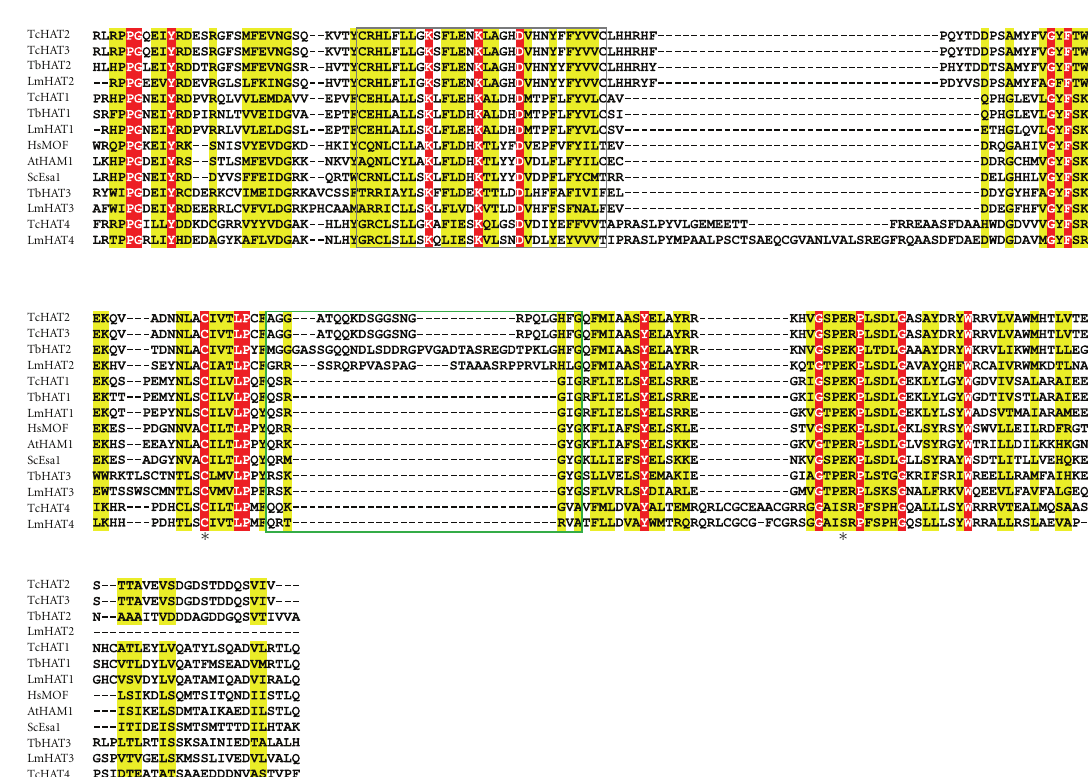
Figure 1: MYST family histone acetyltransferase orthologues in trypanosomatids. Multiple sequence alignments of the core acetyltransferase domains from Tritryps and other organisms. Sequences were aligned with ClustalX2 followed by manual adjustment and illustrated with ESPript 2.2. Identical residues are white on red background, and residues shared by some organisms are black on yellow background. Asterisks indicate residues that were predicted to form part of the catalytic pocket. The gray box marks the C2HC zinc-binding domain. Motif A that binds acetyl Co-A is indicated with a green box. Tb, Trypanosoma brucei ; Tc, Trypanosoma cruzi ; Lm, Leishmania mayor; At, Arabidopsis thaliana ; Hs, human; Sc, Saccharomyces cerevisiae; AcuC, acetoin